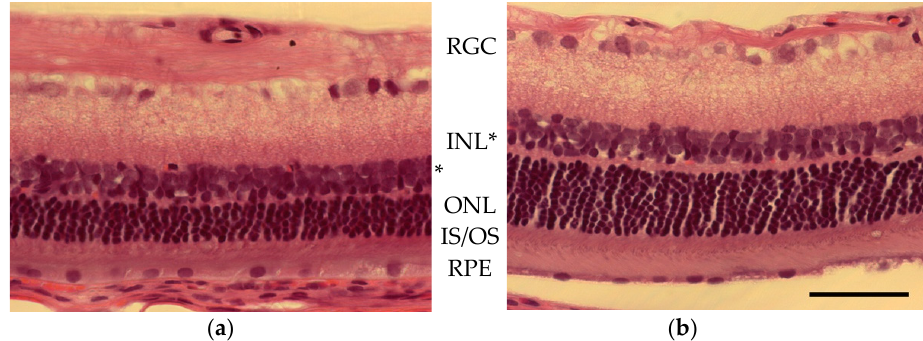
Figure 5. Photographs from a section of retina approximately 1.3 mm inferior to the ONH in ( a ) light ‐ damaged and ( b ) control animal (hematoxylin and eosin stained). Cell body layers labeled from the top of the images; GCL (ganglion cell layer), (INL) inner nuclear layer (indicated with an asterisk * due to changes in retinal thickness), ONL (outer nuclear layer), IS/OS (the inner/outer segment of the photoreceptors), and RPE (retinal pigmented epithelium). Scale bar = 50 μ m.